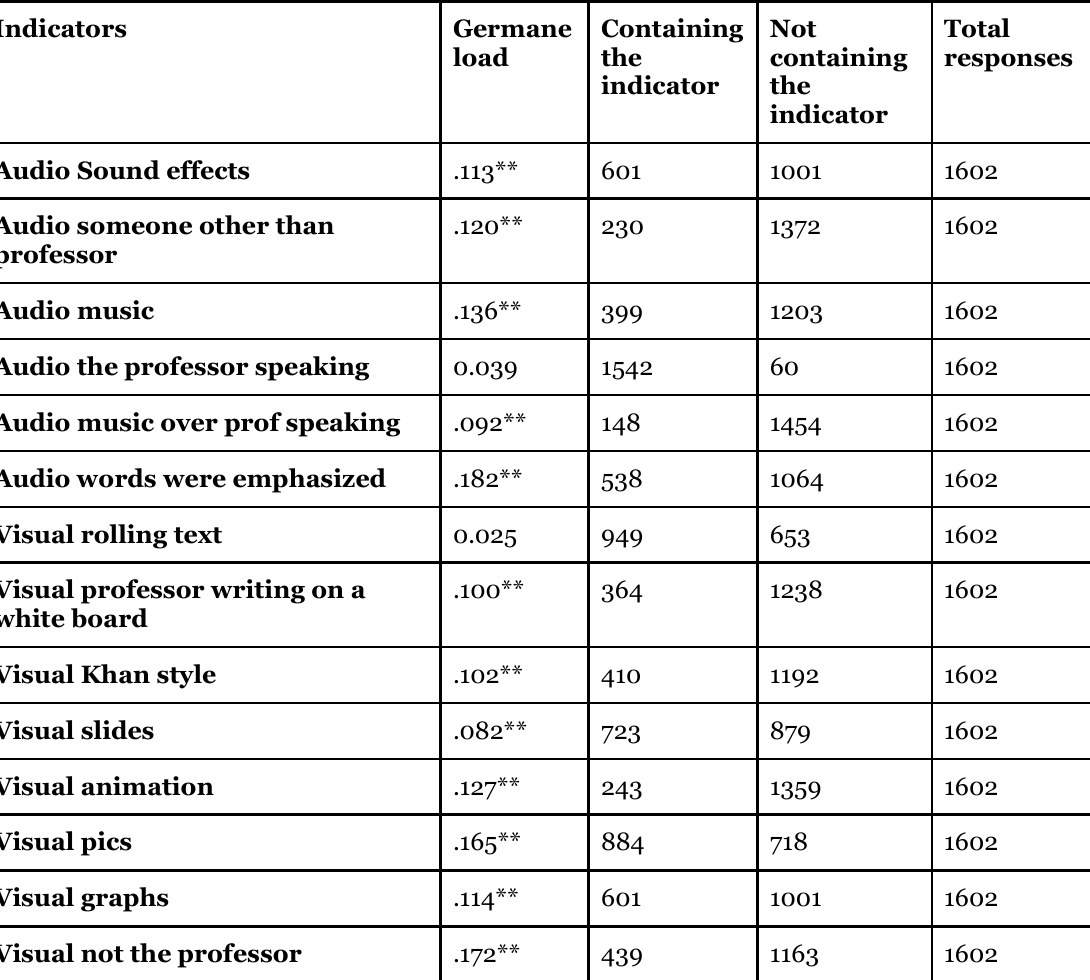
Table 3 Indicators and Their Correlations with Germane Load and Occurrence of the Indicators